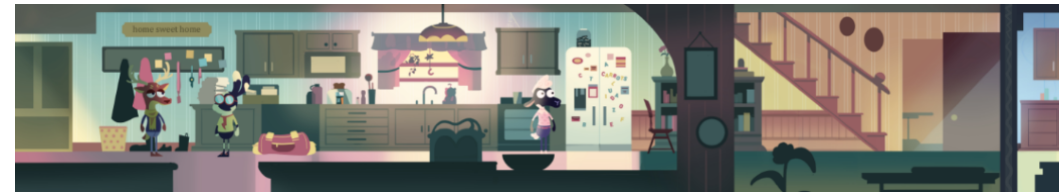
Figure 4. Home scenario in the game.